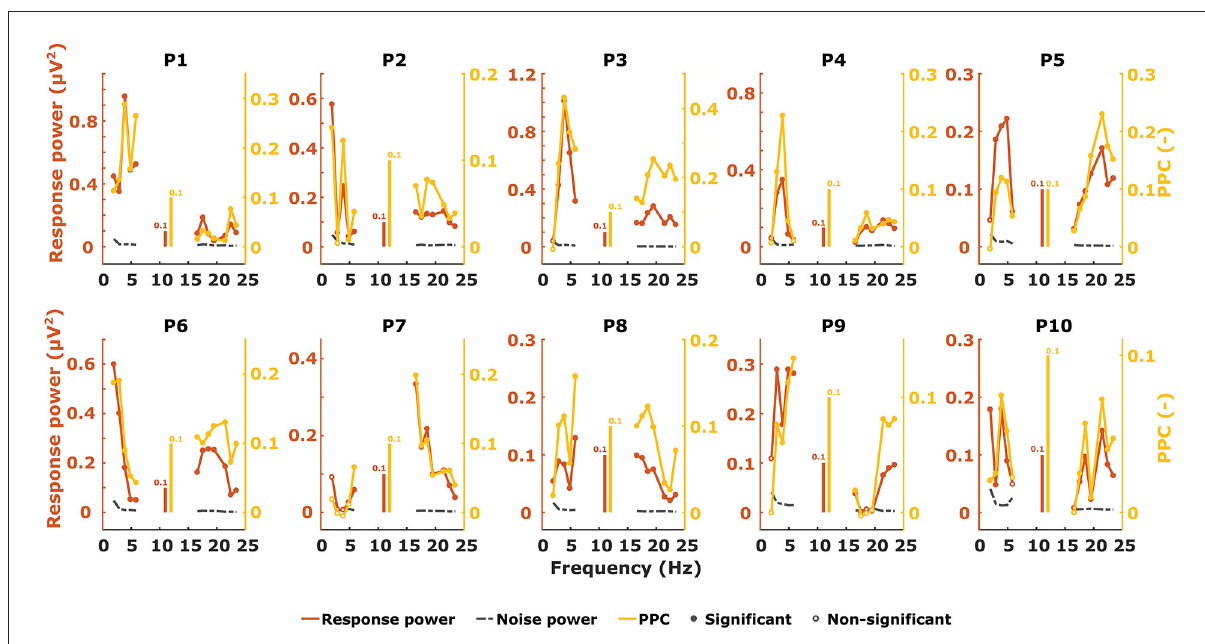
FIGURE4 Unweighted ASSR power (red), noise (black), and PPC (yellow) patterns from the left hemispheric channel as a function of modulation